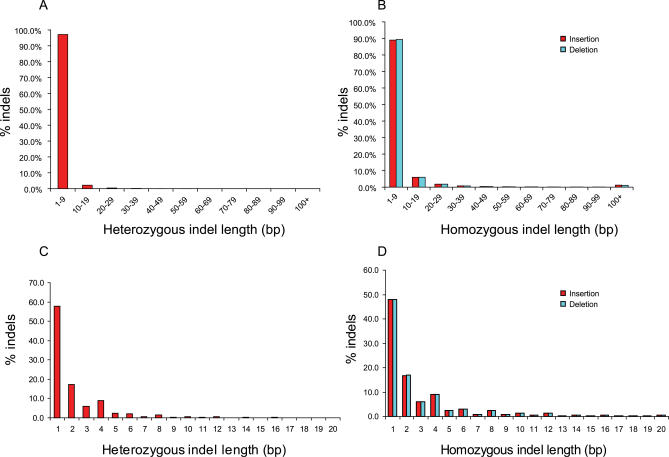
Distribution of Indel Length in the HuRef GenomeDistributions of heterozygous (A) and homozygous (B) indels lengths of 1–100 bp (A and B, respectively) and at greater detail in the range 1–20 bp (C and D, respectively). Note that heterozygous indels range from 1–321 bp and homozygous indels between 1–82,711 bp, however both polymorphisms type have greater than 47% of indel events being single base. Also even-length indels appear to be overrepresented.